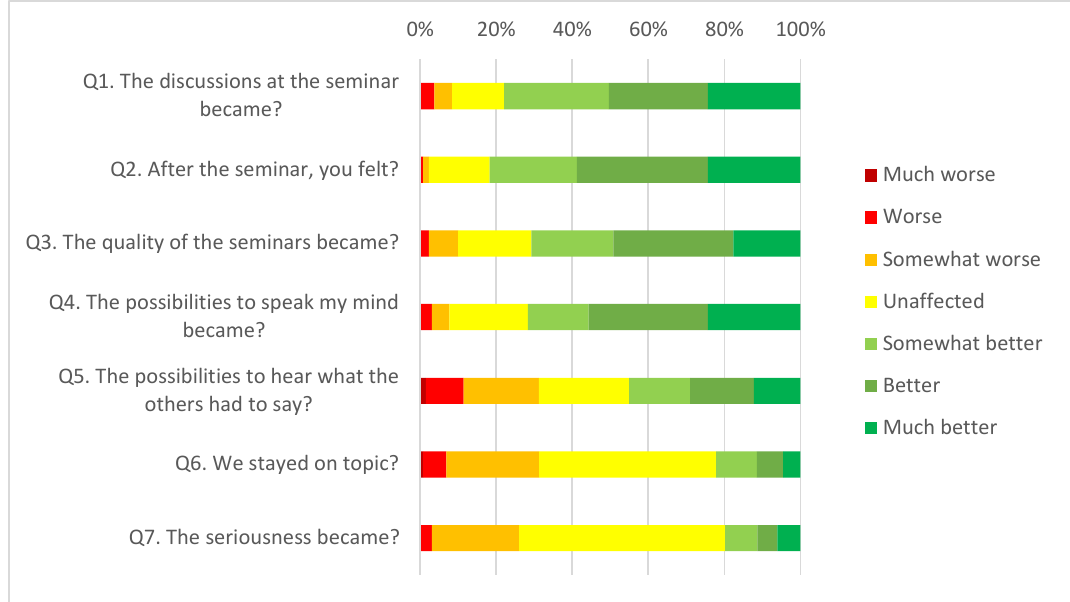
Figure 1. Perceived changes when comparing the previous indoor seminars to the outdoor seminars. n = 131.